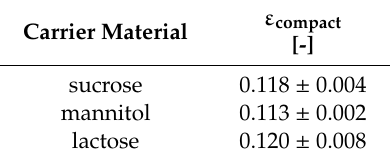
Table 3. Porosity of carrier compacts (and corresponding standard deviations (n = 3)) used for the determination on the apparent intrinsic dissolution rate of carrier materials according to Ph. Eur. 2.9.29.